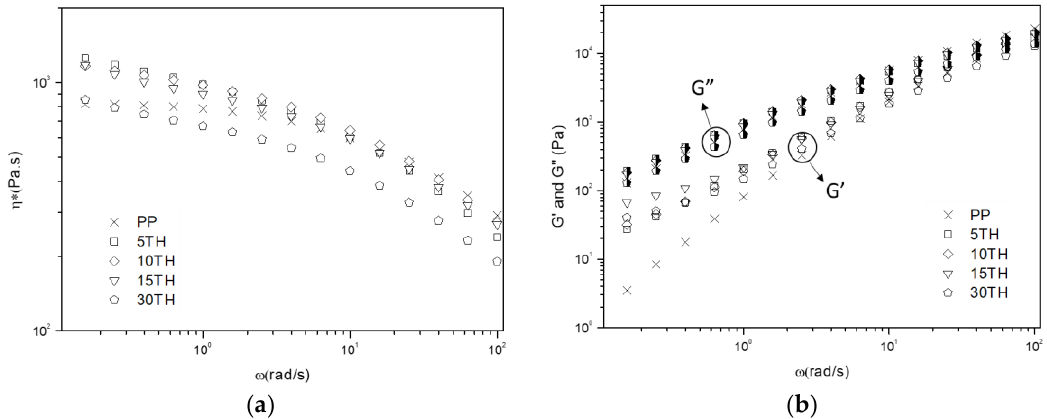
Figure 4. Rheology behavior of PP and PP/TH composites: ( a ) Complex viscosity η* ; ( b ) Storage modulus G′ and Loss modulus G″.